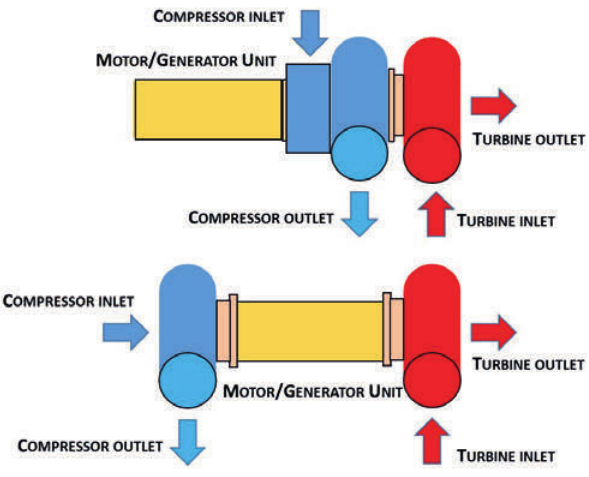
Fig. 2: Schematic of a turbocharger with a motor/generator unit side of compressor (top) or between compressor and turbine (bot- tom) as used in